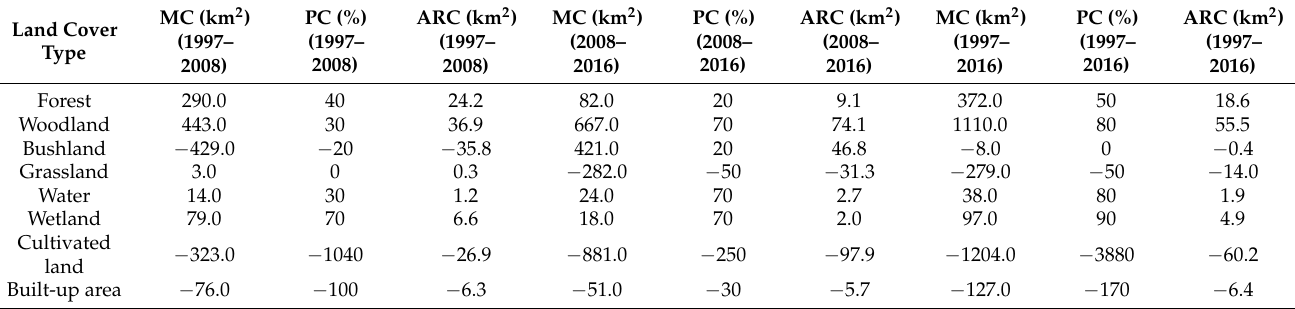
Table 6. The magnitude of change, percentage of change, and the annual rate of change for land cover classes in the Kimbiji aquifer.